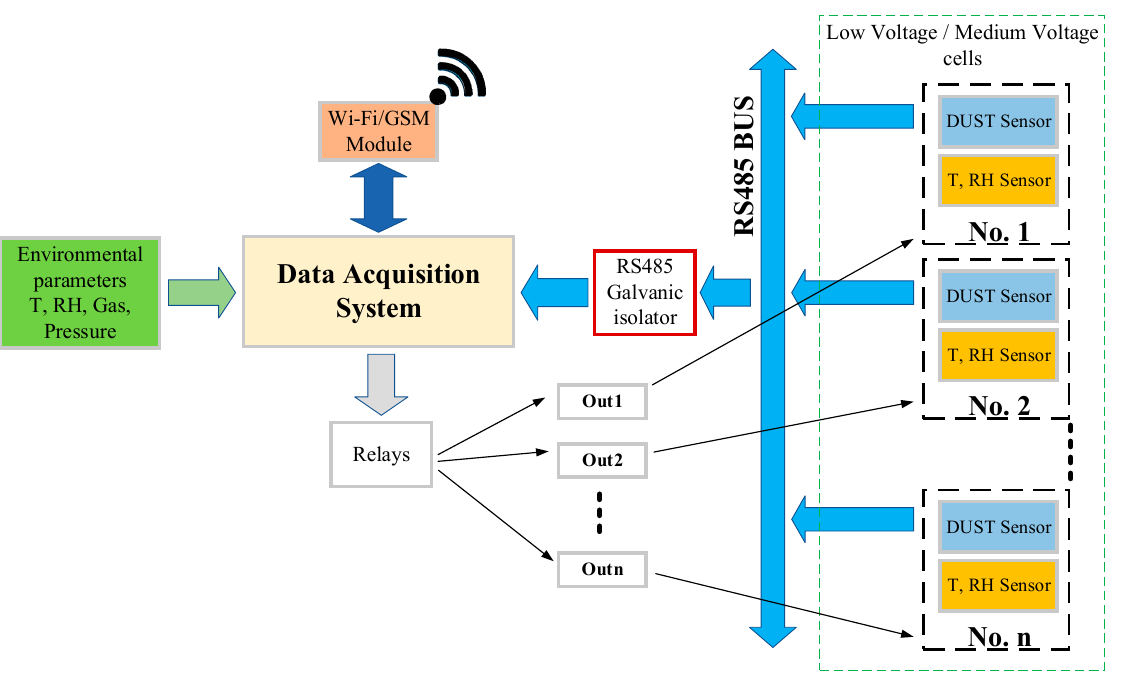
Figure 7. Base schematic proposal for microclimate monitoring in LV/MV cells.